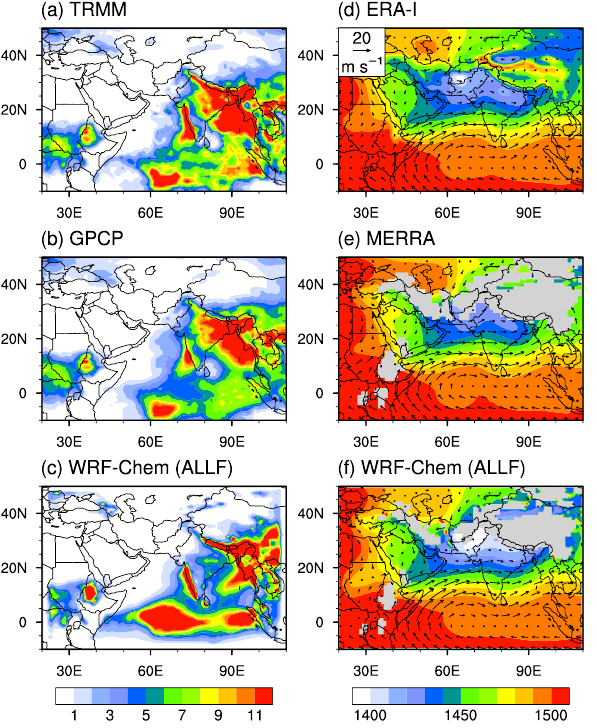
Figure 3. Spatial patterns of AOD (unitless) from (a) MISR (558nm), (b) MODIS Aqua (550 nm), (c) MACC (550 nm), (d) MODIS Terra (550nm), (e) WRF-Chem (ALLF; 550nm), and (f) WRF-Chem (NDST; 550nm) averaged for JJA 2008. Missing values are marked in gray in (a) , (b) and (d)